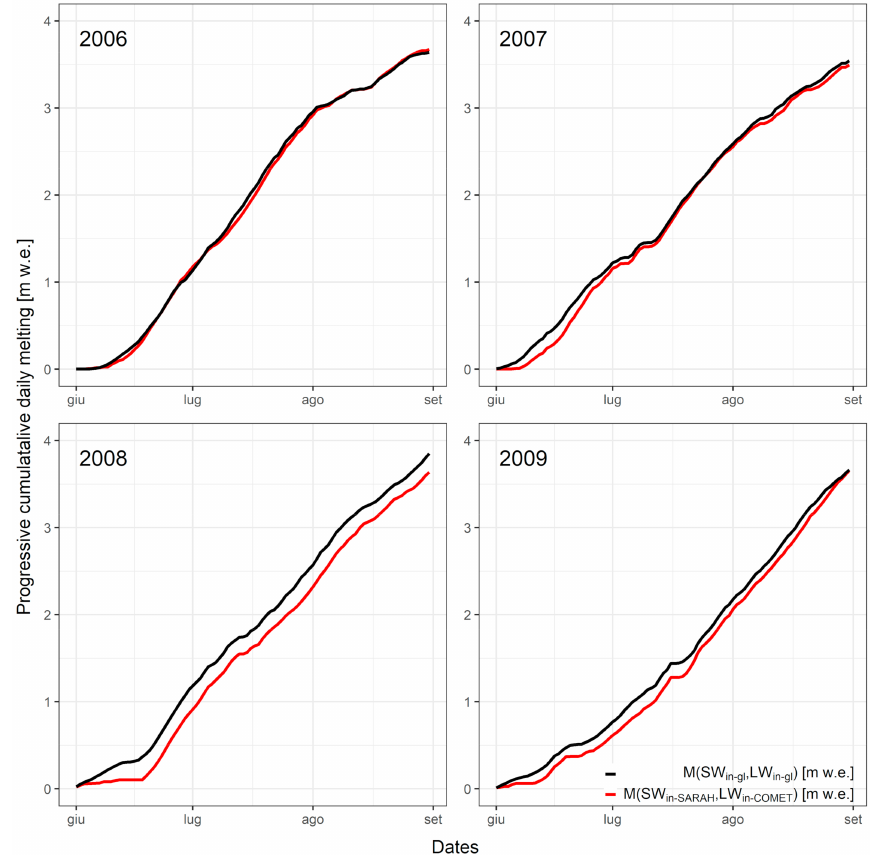
Figure 3. Progressive cumulative daily melting (m w.e.) for the four years of the 2006–2009 period obtained from M(SW in-SARAH ,LW in-COMET ) (red line) and M(SW in-gl ,LW in-gl ) (black